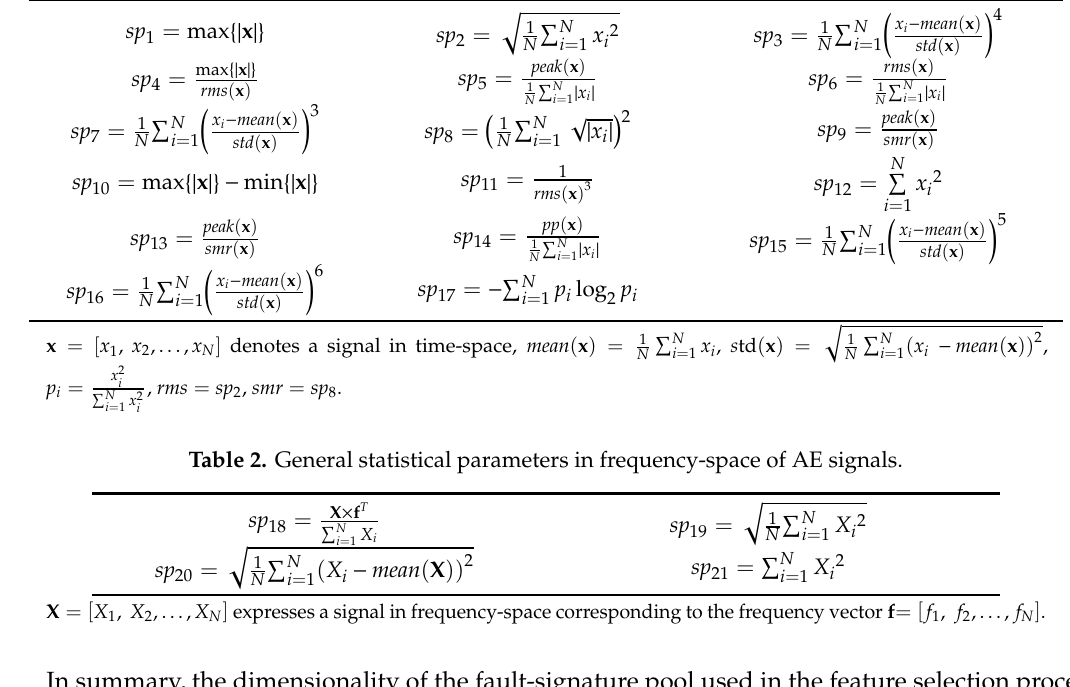
Table 1. General statistical parameters in time-space of acoustic emission (AE) signals.